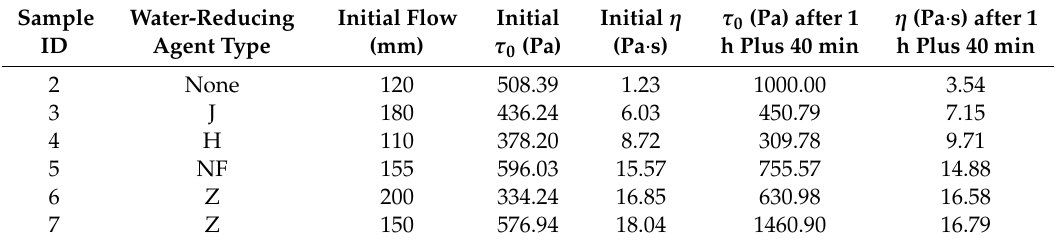
Table 7. The fluidity and compressive strength of cement